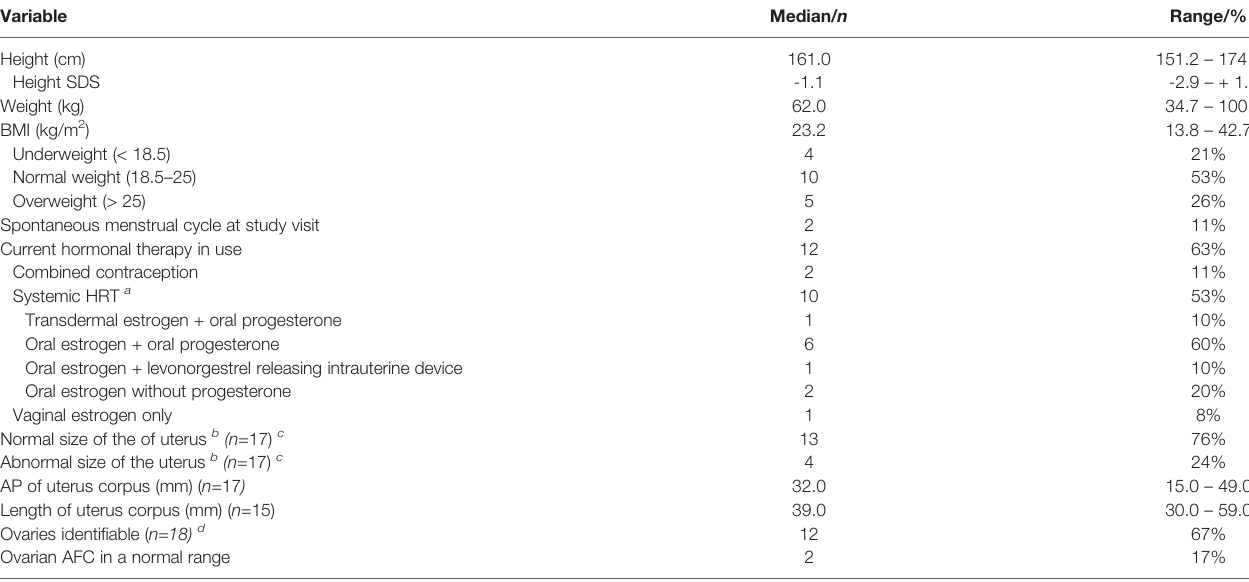
TABLE 2 | Patient characteristics, state of hormonal replacement therapy, and ultra-sound measurements at the time of appointment in the 19 patients with APECED. Variable